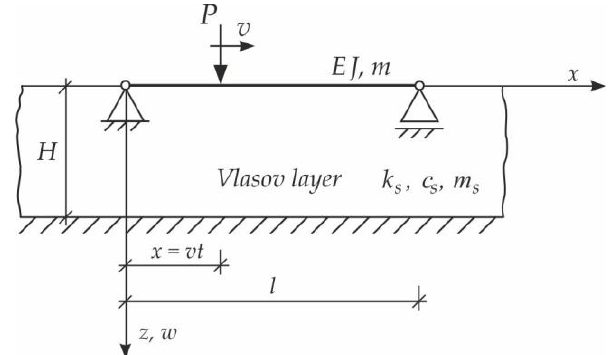
Figure 3. Beam on Vlasov foundation subjected to a moving force.